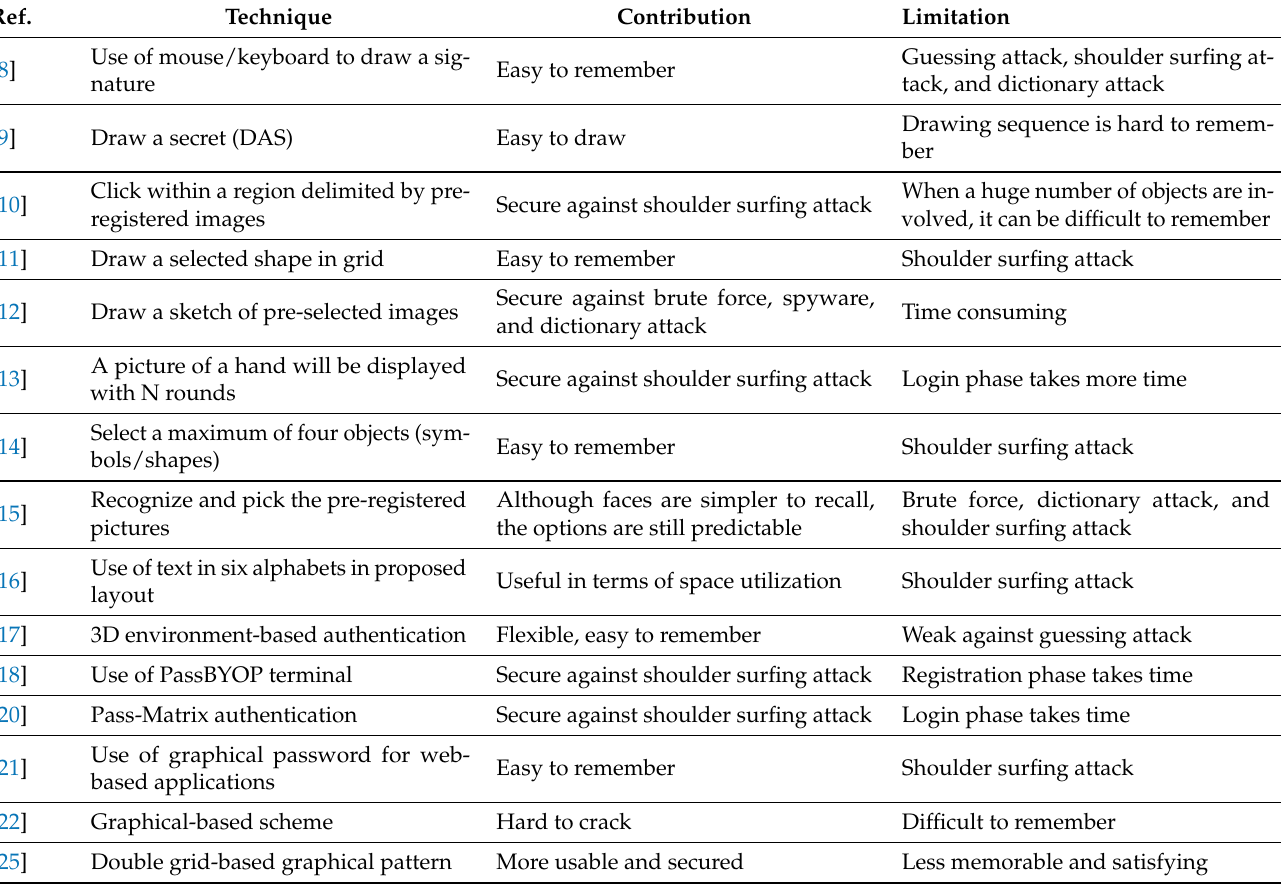
Table 1. Comparison of existing